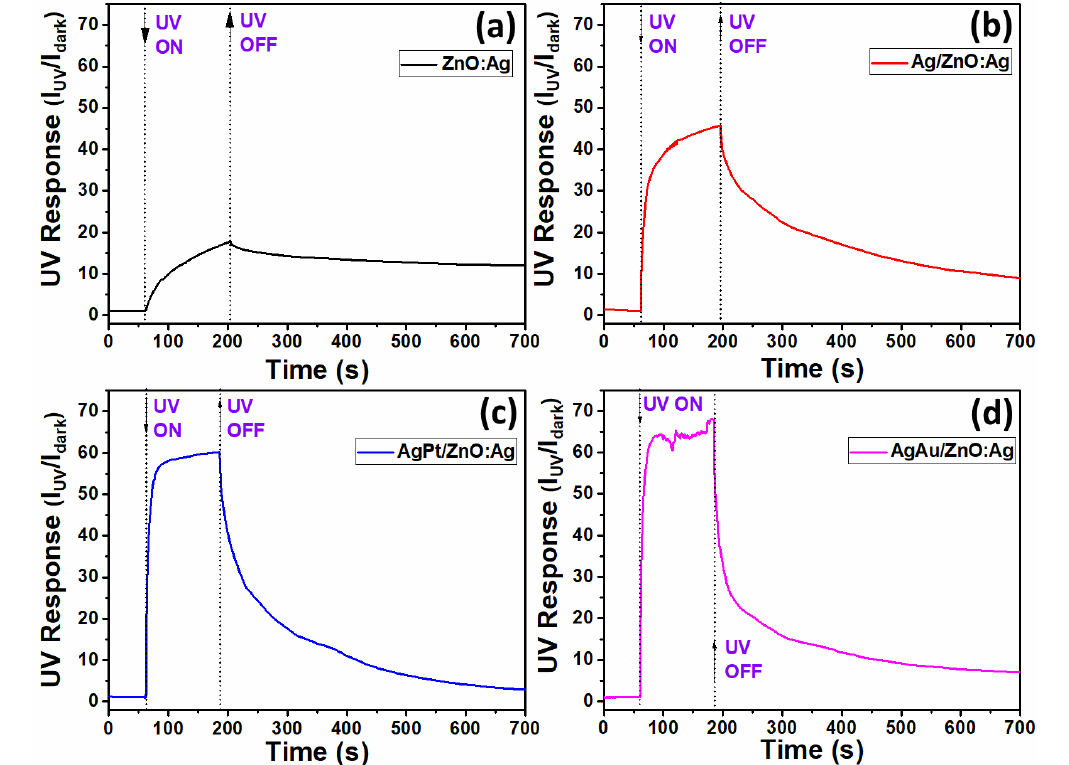
Figure 3. The dynamic UV response for: (a) ZnO:Ag; (b) Ag/ZnO:Ag; (c) AgPt/ZnO:Ag and (d) AgAu/ZnO:Ag nanostructured films.